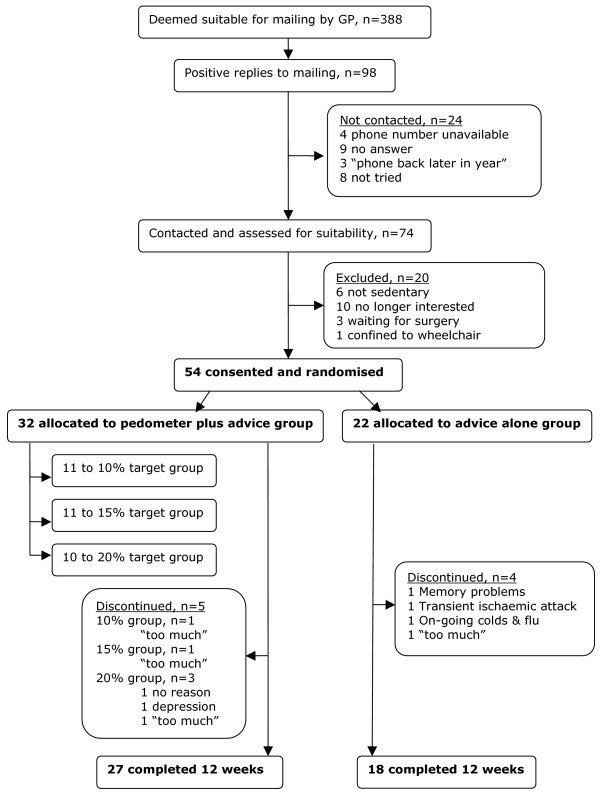
Consort diagram.